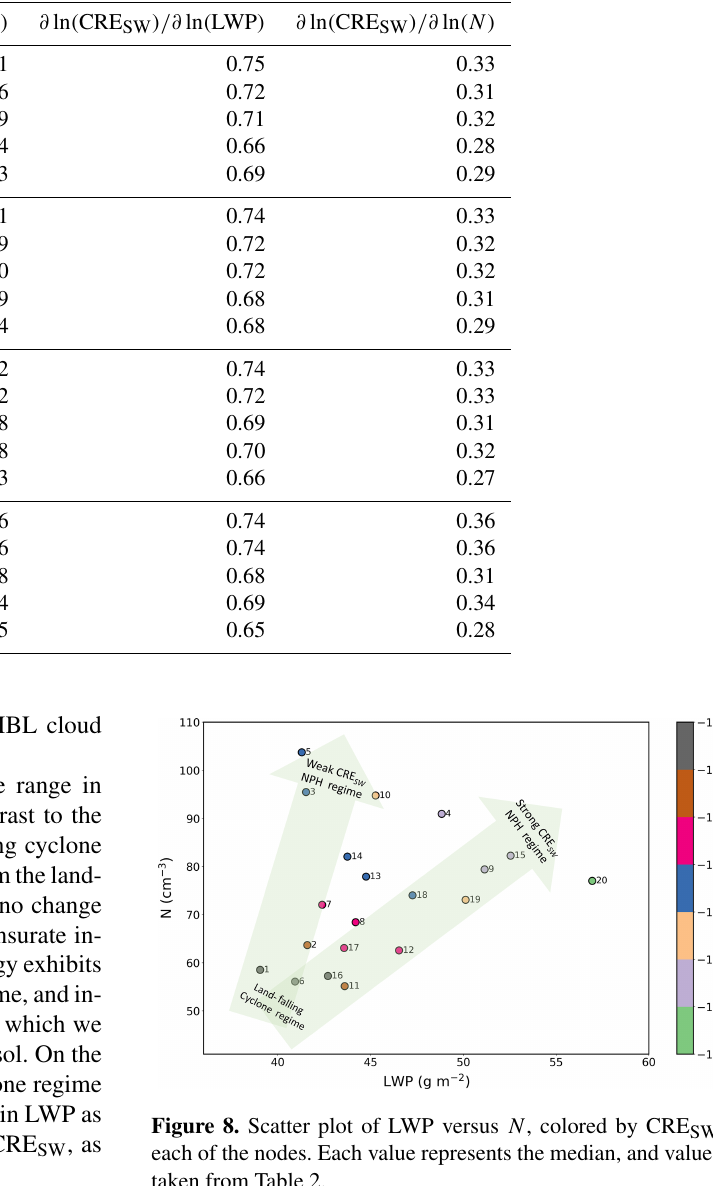
Table 3. Susceptibility parameters calculated for each node. Here we use the same data that are used to calculate the values in Table 2; that is, the susceptibility for each node is based on the linear regression of all spatial points located within the oceanic area shown in Figs. 3, 5, and 6 and of all MODIS retrieval times associated with that node.